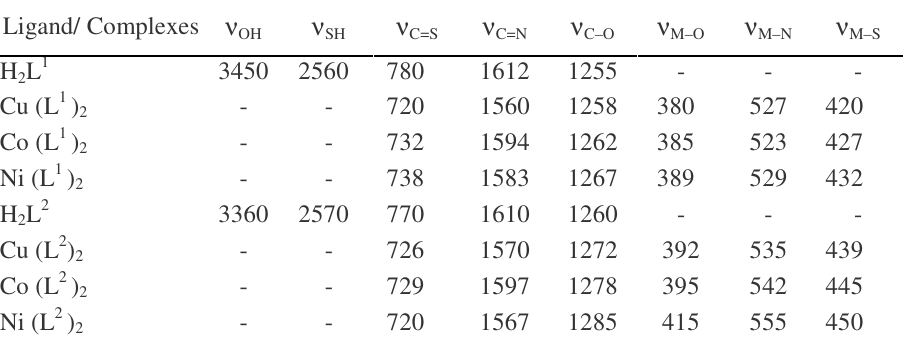
L 1 & H L 2 and its complexes 2 2